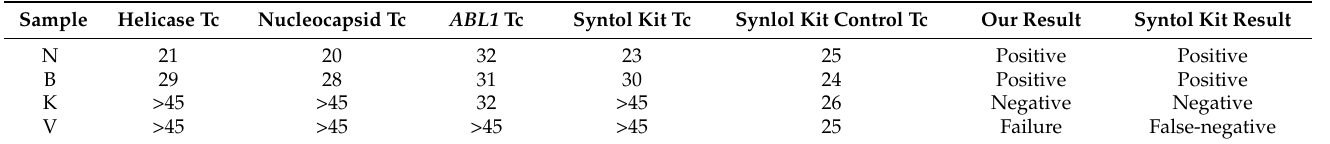
Table 2. Threshold cycles (Tc) and interpretation of results for commercial (Syntol) kit and proposed set of